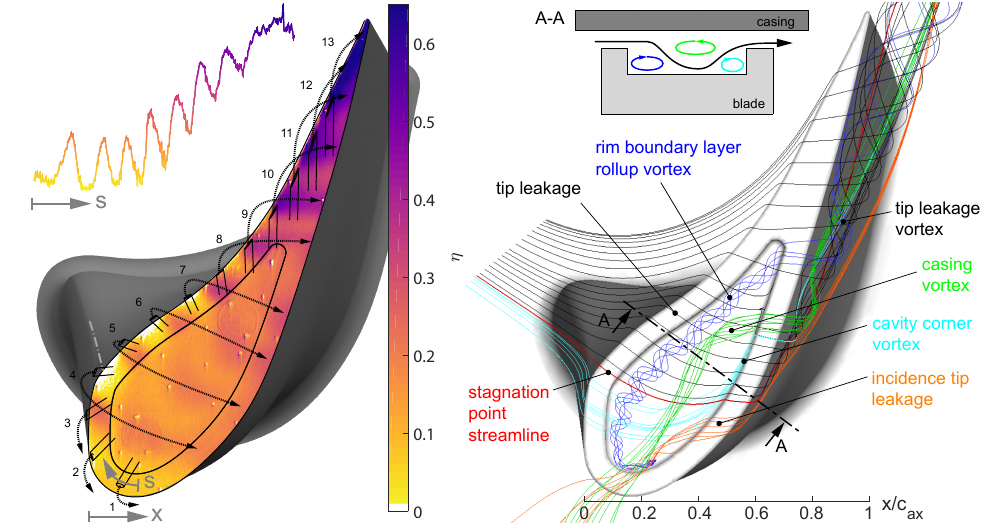
Figure 6. Axial inflow